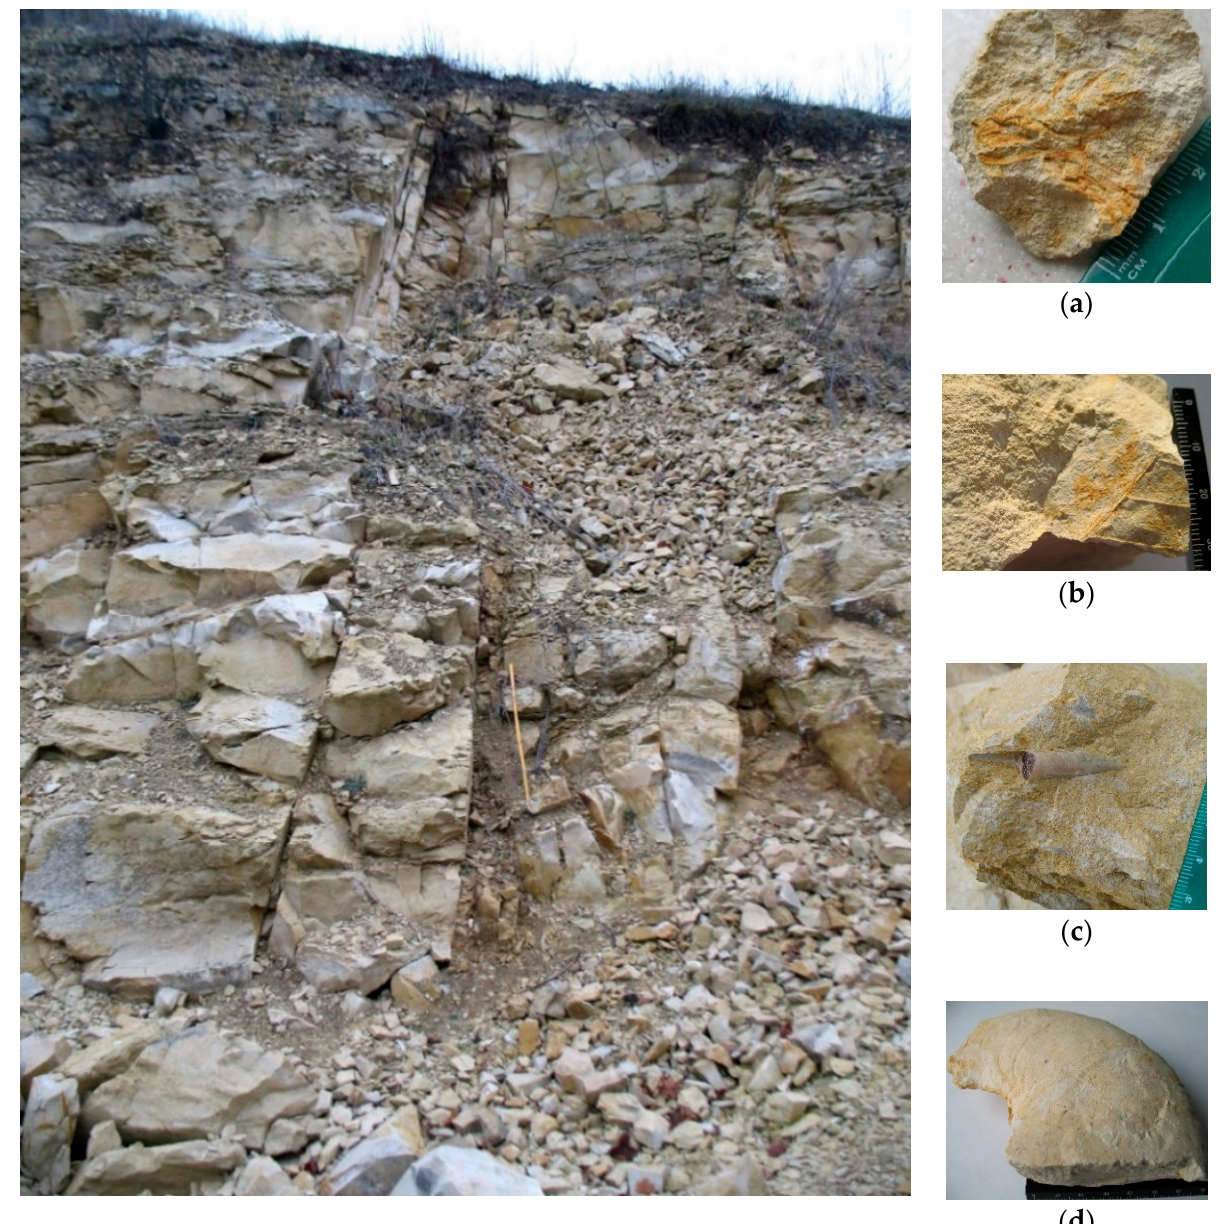
Figure 3. Late Cretaceous opokas in Krasnobród quarry with fossils of: ( a ) coniferous plant Geinitzia , ( b ) leafy plant Debeya paulinae [40,41], ( c ) Belemnitella junior Nowak, ( d ) Hoploscaphites constrictus [42].